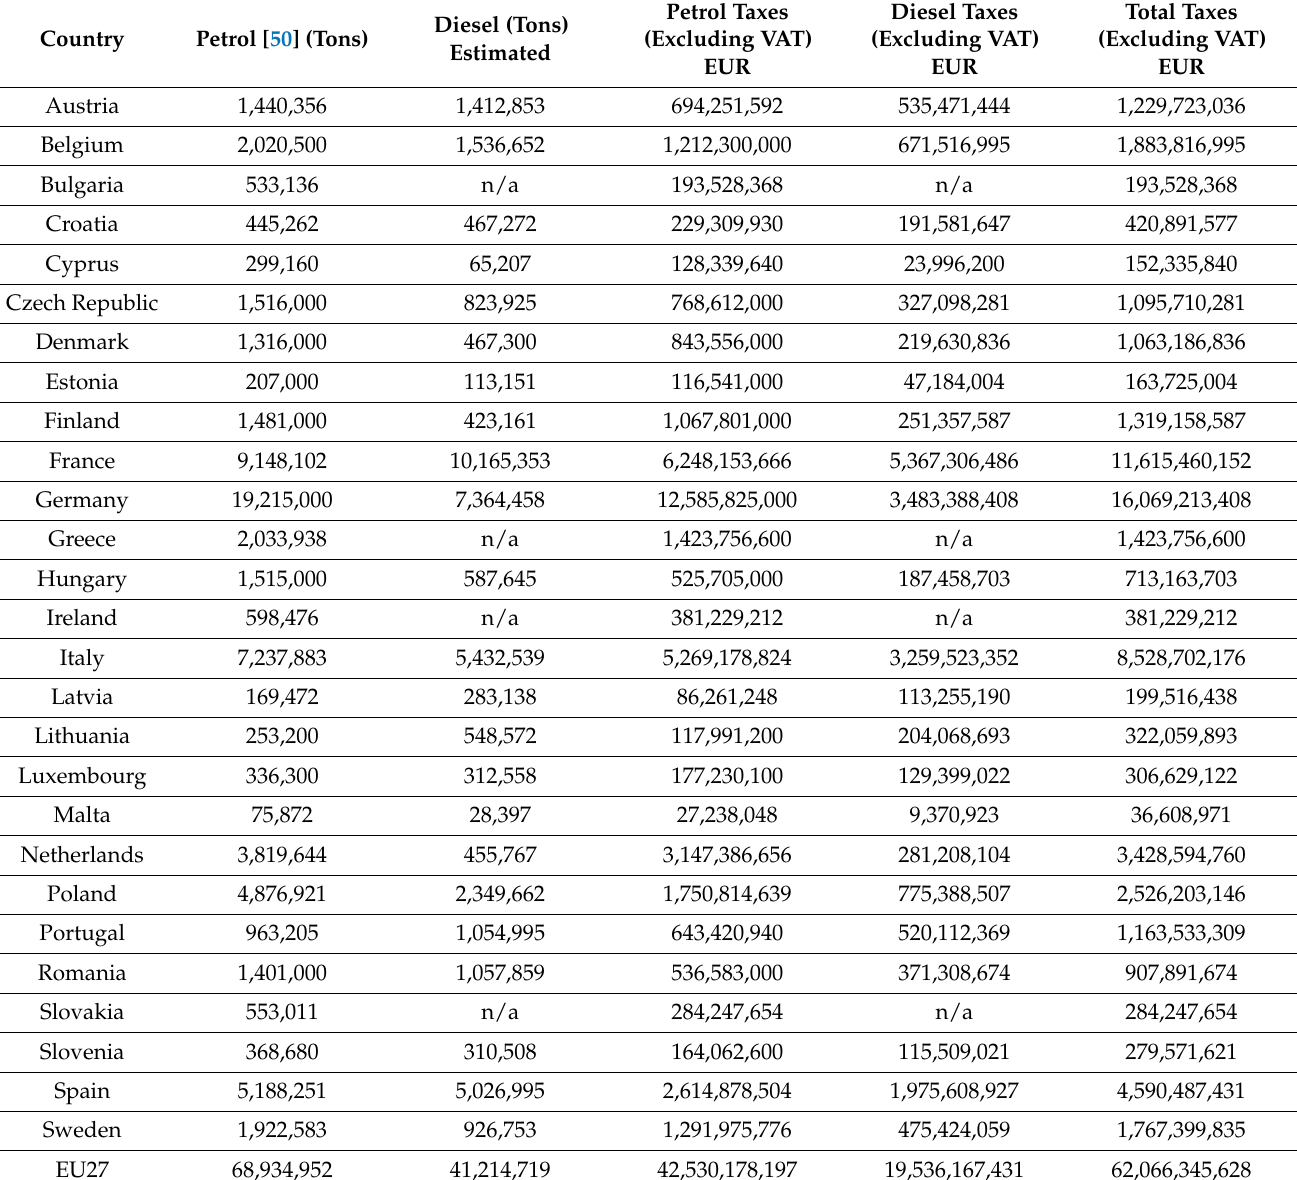
Table 6. Fuel consumption in 2021 and corresponding taxes. Source: own elaborations.